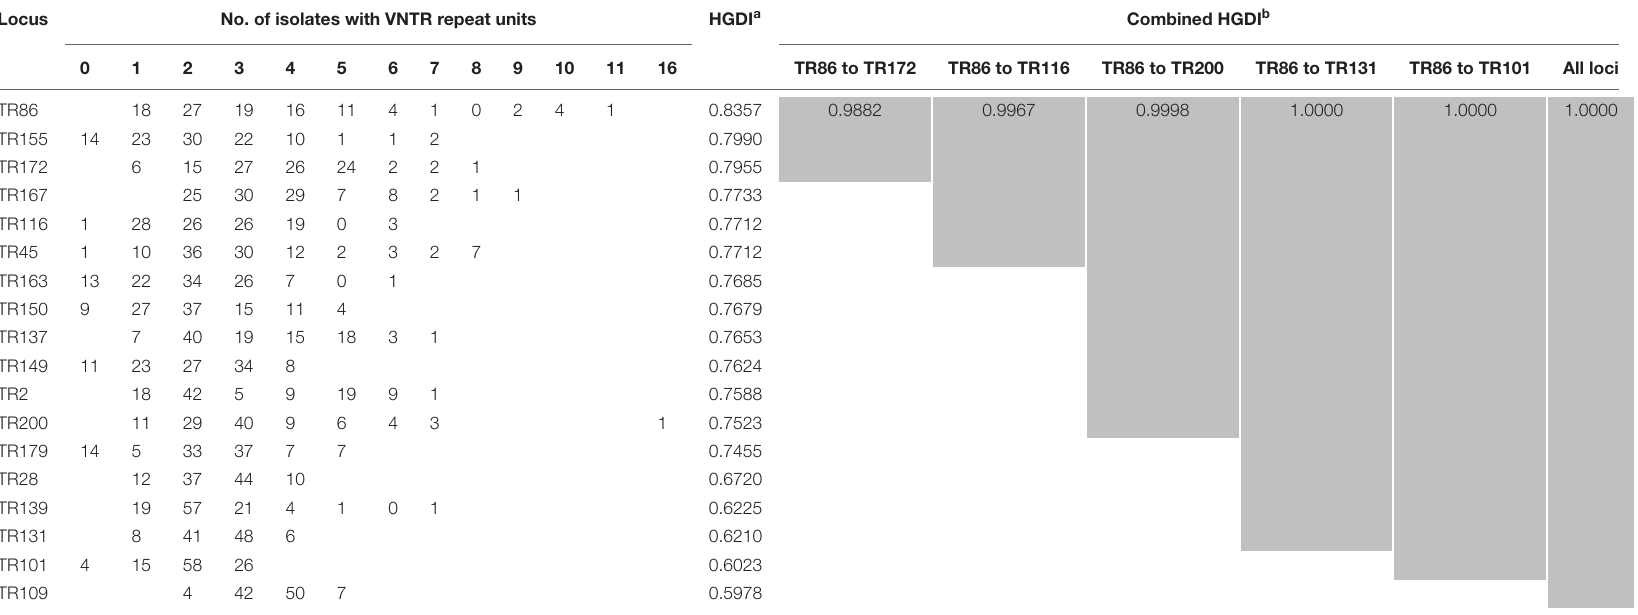
TABLE 2 | Combined HGDI for 103 independent Mycobacterium abscessus complex (MABC) isolates. Locus No. of isolates with VNTR repeat